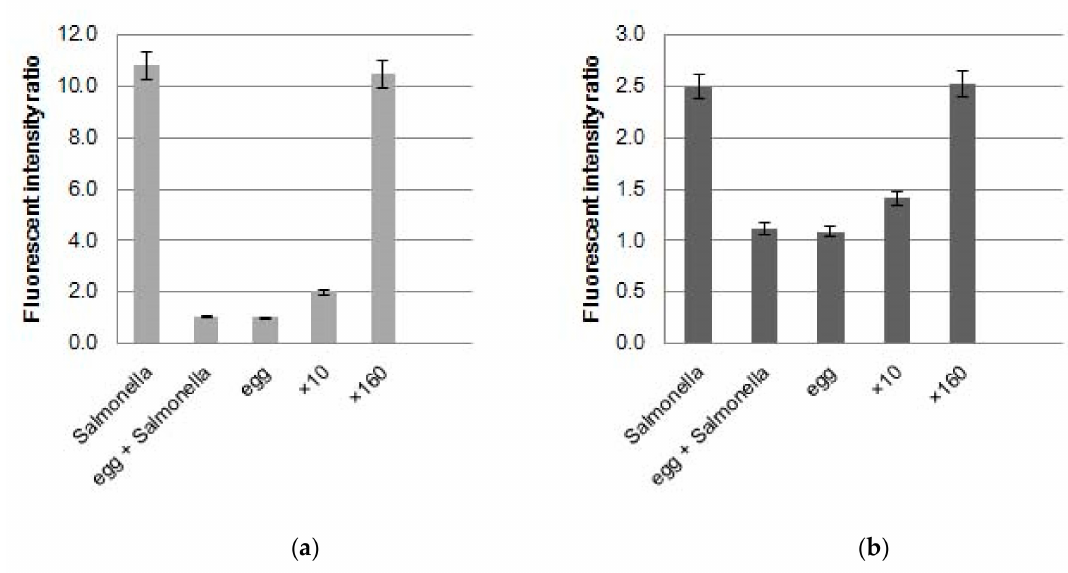
Figure 3. E ff ect of egg yolk components on fluorescence intensity via PCR: ( a ) PCR signal of 6-carboxyfluorescein (FAM) from the invA gene; ( b ) PCR signal of X-Rhodamine (ROX) from the internal control, N = 3.